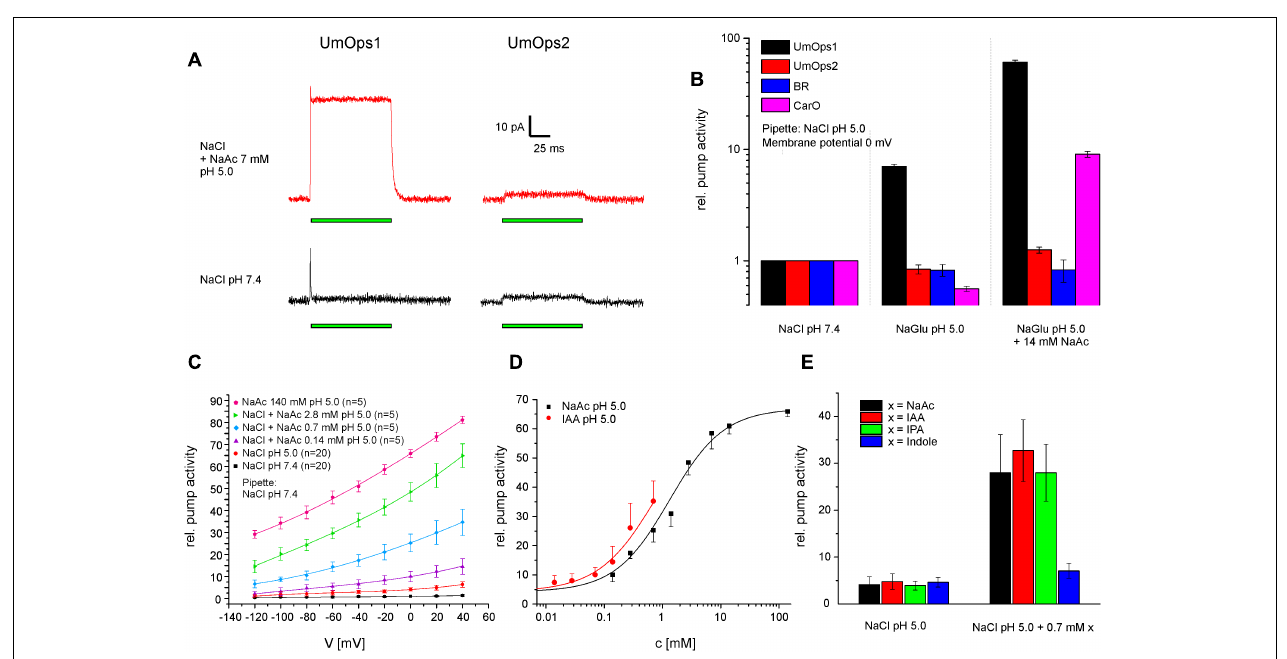
FIGURE 4 | Effect of WOAs on the pump activity of U. maydis rhodopsins. (A) Typical whole cell traces showing the light-induced charge transfer by UmOps1 and UmOps2 (time of illumination is indicated by the green bar). The pump intensity of UmOps1 strongly increased in the presence of weak organic acids at external pH 5.0 (upper raw) compared to NaCl pH 7.4 (lower raw), while no such effect could be observed with UmOps2. (B) Mean relative pump activity and standard deviation of at least five experiments of UmOps1 and UmOps2 in comparison with BR and CarO (data were obtained from Adam et al., 2018) at 0 mV holding potential in NaCl pH 7.4, NaCl pH 5.0, and NaCl pH 5.0 supplemented with 14 mM sodium acetate. Note that only UmOps1 (similar to CarO) shows a clear response to acetate while UmOps2 does not. (C) Current–voltage relation of UmOps1 light-induced pump current in the presence of different concentrations of sodium acetate. (D) Dose-response of UmOps1 pump activity in sodium acetate and IAA. The sodium acetate data were described by a Hill function, revealing a k -value of 1.32 ± 0.18 mM. (E) Mean current and standard deviation of at least five experiments of UmOps1 pump activity in NaCl pH 5.0 and after adding 0.7 mM of different WOAs as indicated. Only the compounds with an acetate group showed a strong supporting effect on the pump